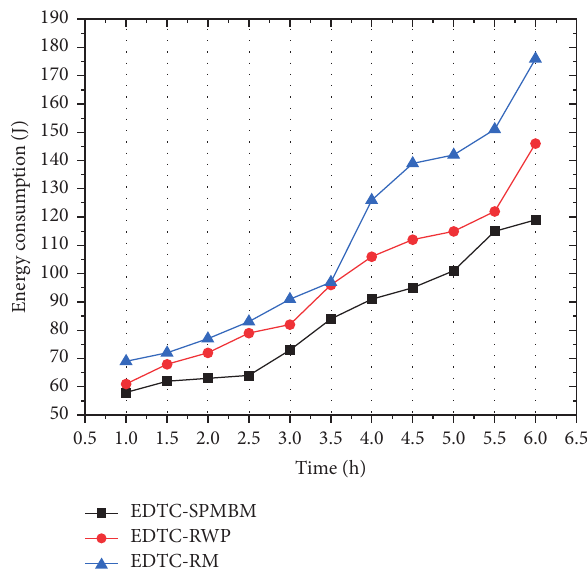
Figure 20: Relationship between delivery ratio and time in three mobile